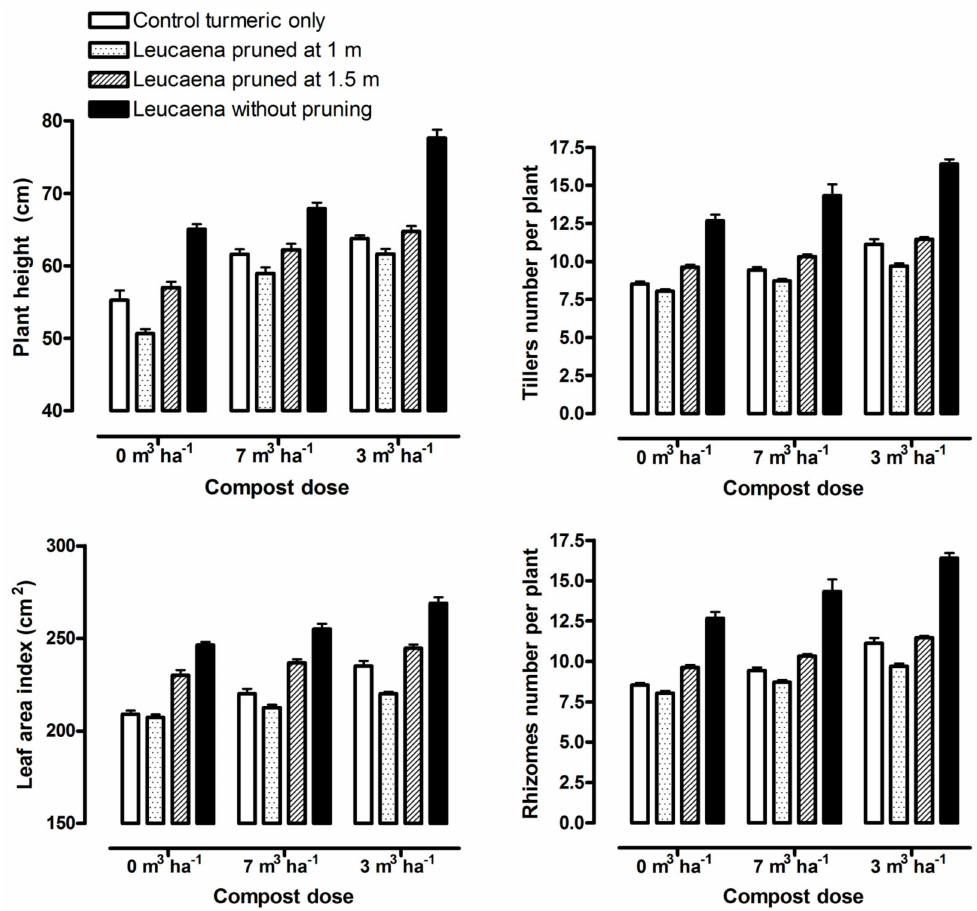
Figure 1. Plant height (cm), tiller number per plant, leaf-area index (cm 2 ) and number of rhizomes per plant of Curcuma longa in response to alley-cropping and organic-compost treatments as pooled data of the two seasons of 2021 and